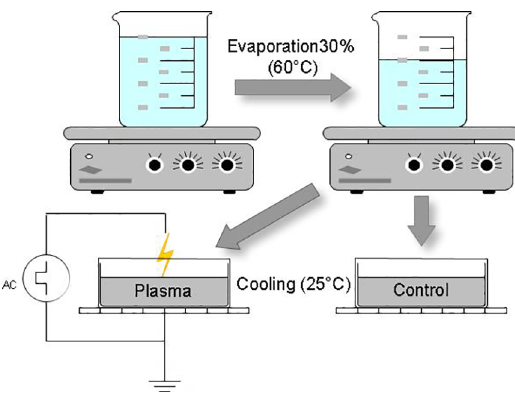
Figure 2. Experiment 2